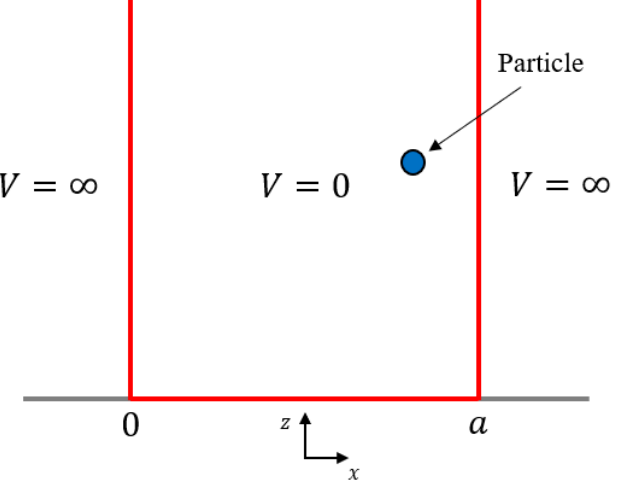
Figure 3. Infinite potential well.